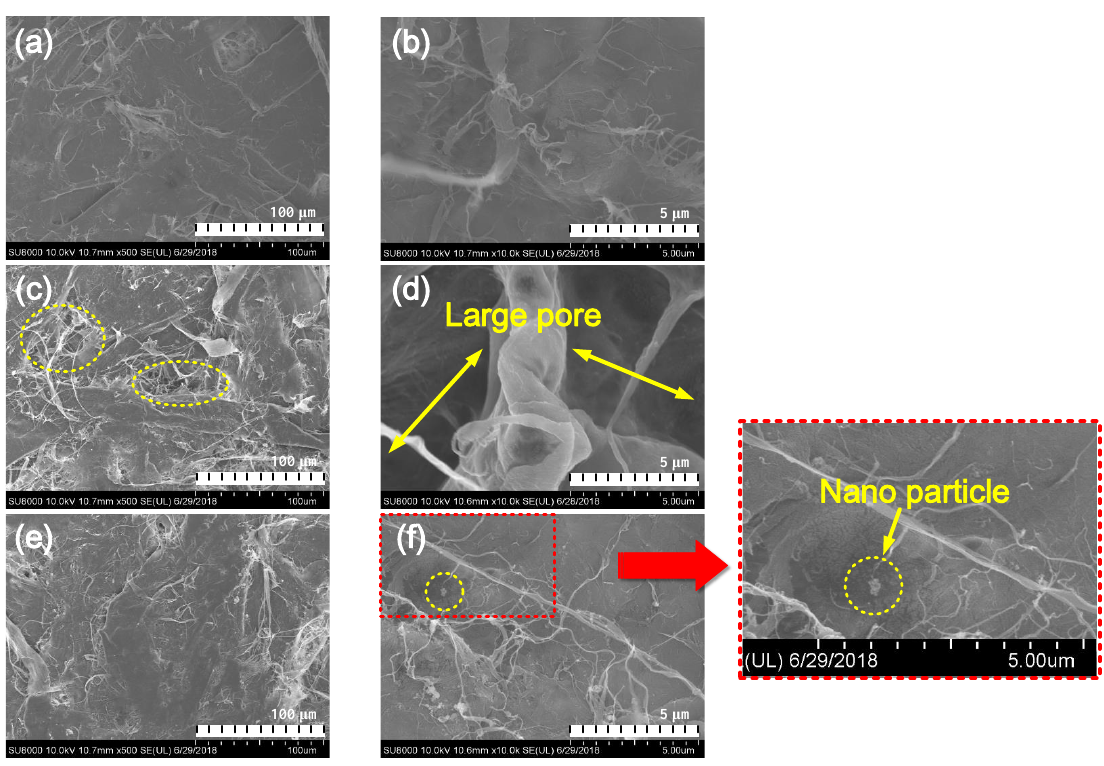
Figure 22. Scanning electron microscope (SEM) images of OIP and NOIP: ( a , b ) fresh OIP (magnified 500 and 10,000 times, respectively), ( c , d ) fresh OIP subjected to 500 impulses (magnified 500 and 10,000 times, respectively), ( e , f ) NOIP subjected to 500 impulses (magnified 500 and 10,000 times, respectively).